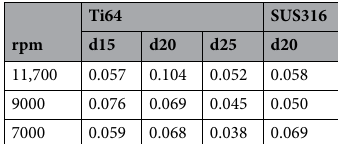
Table 1. Hi numbers corresponding to the experimental conditions shown in Fig.